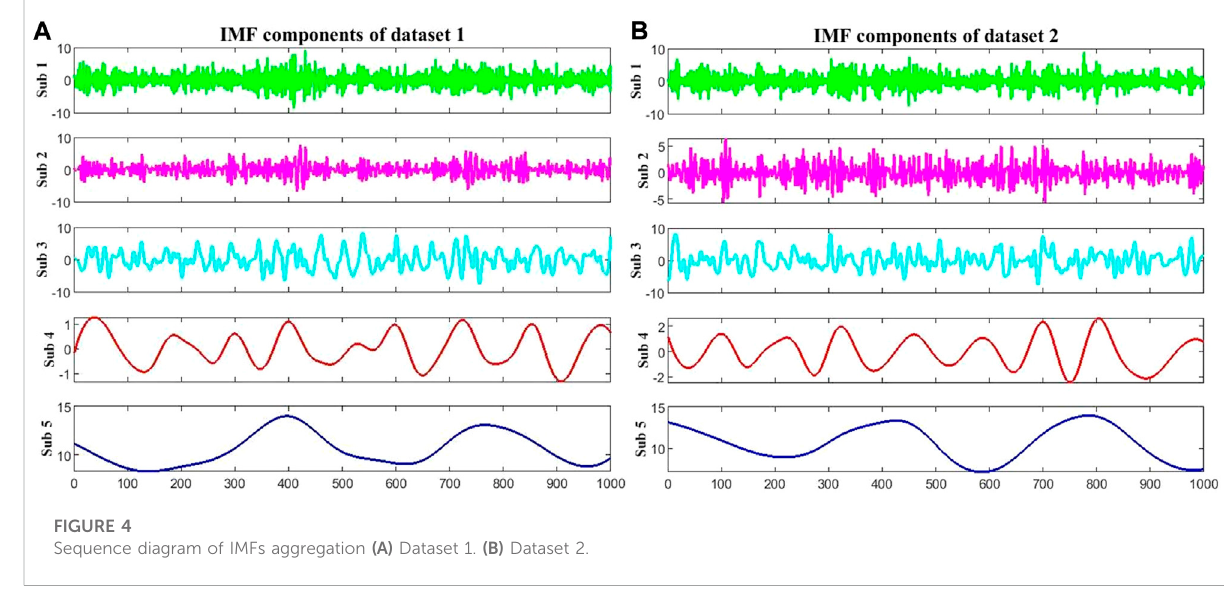
FIGURE 4 Sequence diagram of IMFs aggregation (A) Dataset 1. (B) Dataset 2.